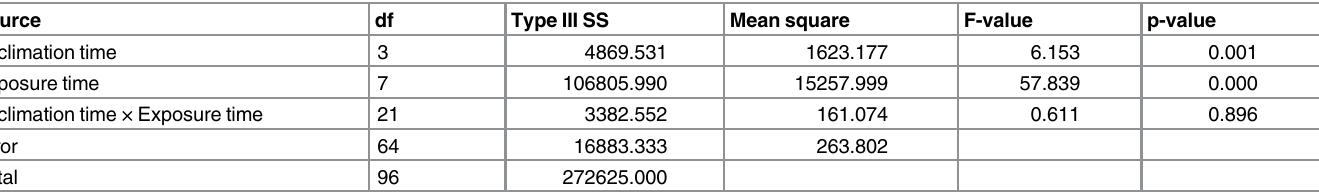
Table 8. Two way analysis of variance (ANOVA) parameters for main effects and associated interactions for the mortality of S . zeamais exposed to 55°C.